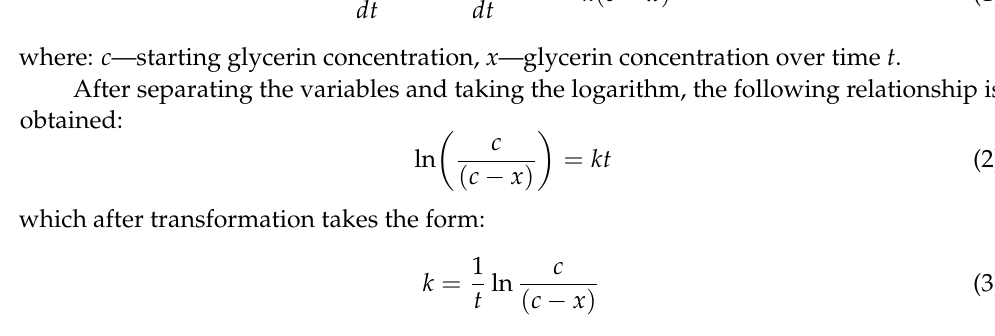
Figure 5. Dependence of glycerol conversion on reaction time determined on the basis of changes in absorbance of the C–O–C band at 1100 cm − 1 recorded in-situ with the FTIR probe. absorbance of the C–O–C band at 1100 cm − 1 recorded in-situ with the FTIR The measured values of the intensity of the band corresponding to the ether group